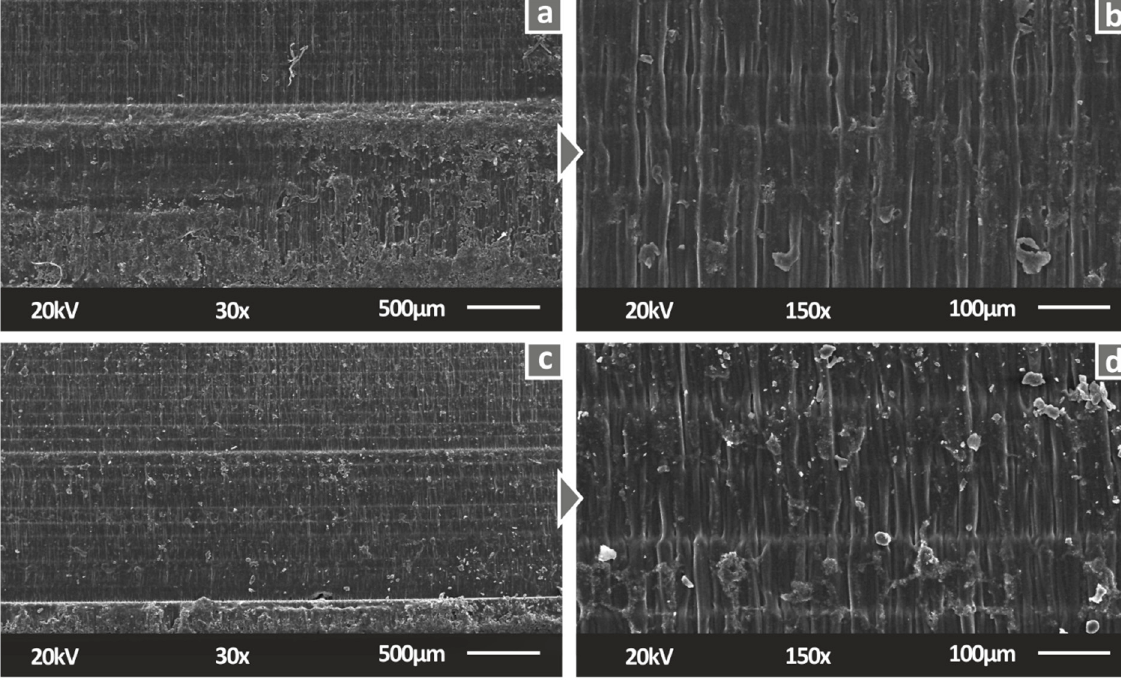
Figure 5. Side surface of tensile specimens in 30× magnification for ( a ) Pure SC, ( c ) SC Cu 2 O 0.5 wt.%, ( e ) SC Cu 2 O 1.0 wt.%, ( g ) SC Cu 2 O 2.0 wt.%, same surfaces in 150× magnification for ( b ) Pure SC, ( d ) SC Cu 2 O 0.5 wt.%, ( f ) SC Cu 2 O 1.0 wt.%, ( h ) SC Cu 2 O 2.0 wt.%. Figure 6 presents SEM images from the fracture area of the tensile specimens. Fol- lowing the side surface analysis, the fracture area provides more information and proof of the deteriorated processing at higher filler ratios in the fabricated nanocomposites. Plausible agglomerations are visible, while the total morphology of the fractal area in the two higher filled nanocomposites exhibited slight voids, which probably occurred due to the pure photopolymerization of the matrix SC resin. The fracture area morphology also exhibits a stiffening effect due to the introduction of Cuprous Oxide in the